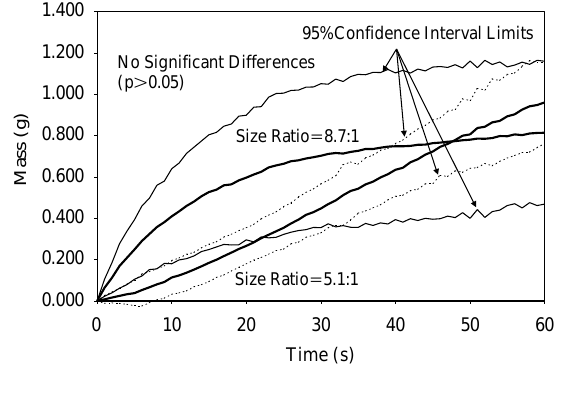
Size Ratio 5.1:1 ( (cid:9) )